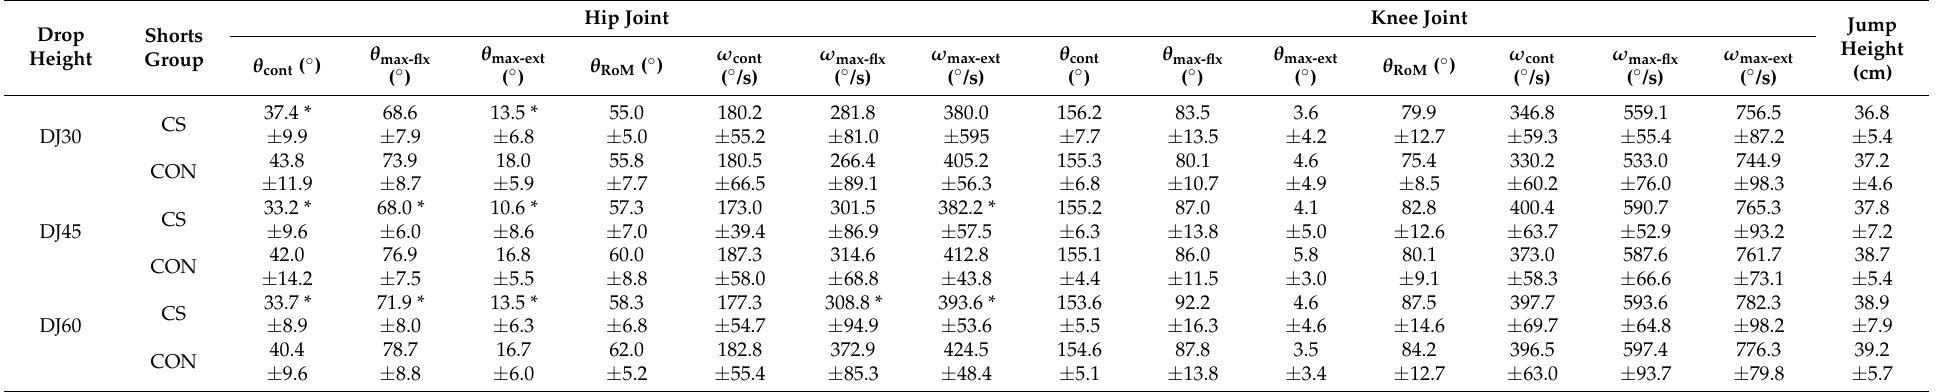
Table 1. Comparison of joint kinematics and jump height (mean ± SD ) of participants wearing CS and CON during DJs at three landing heights. Drop